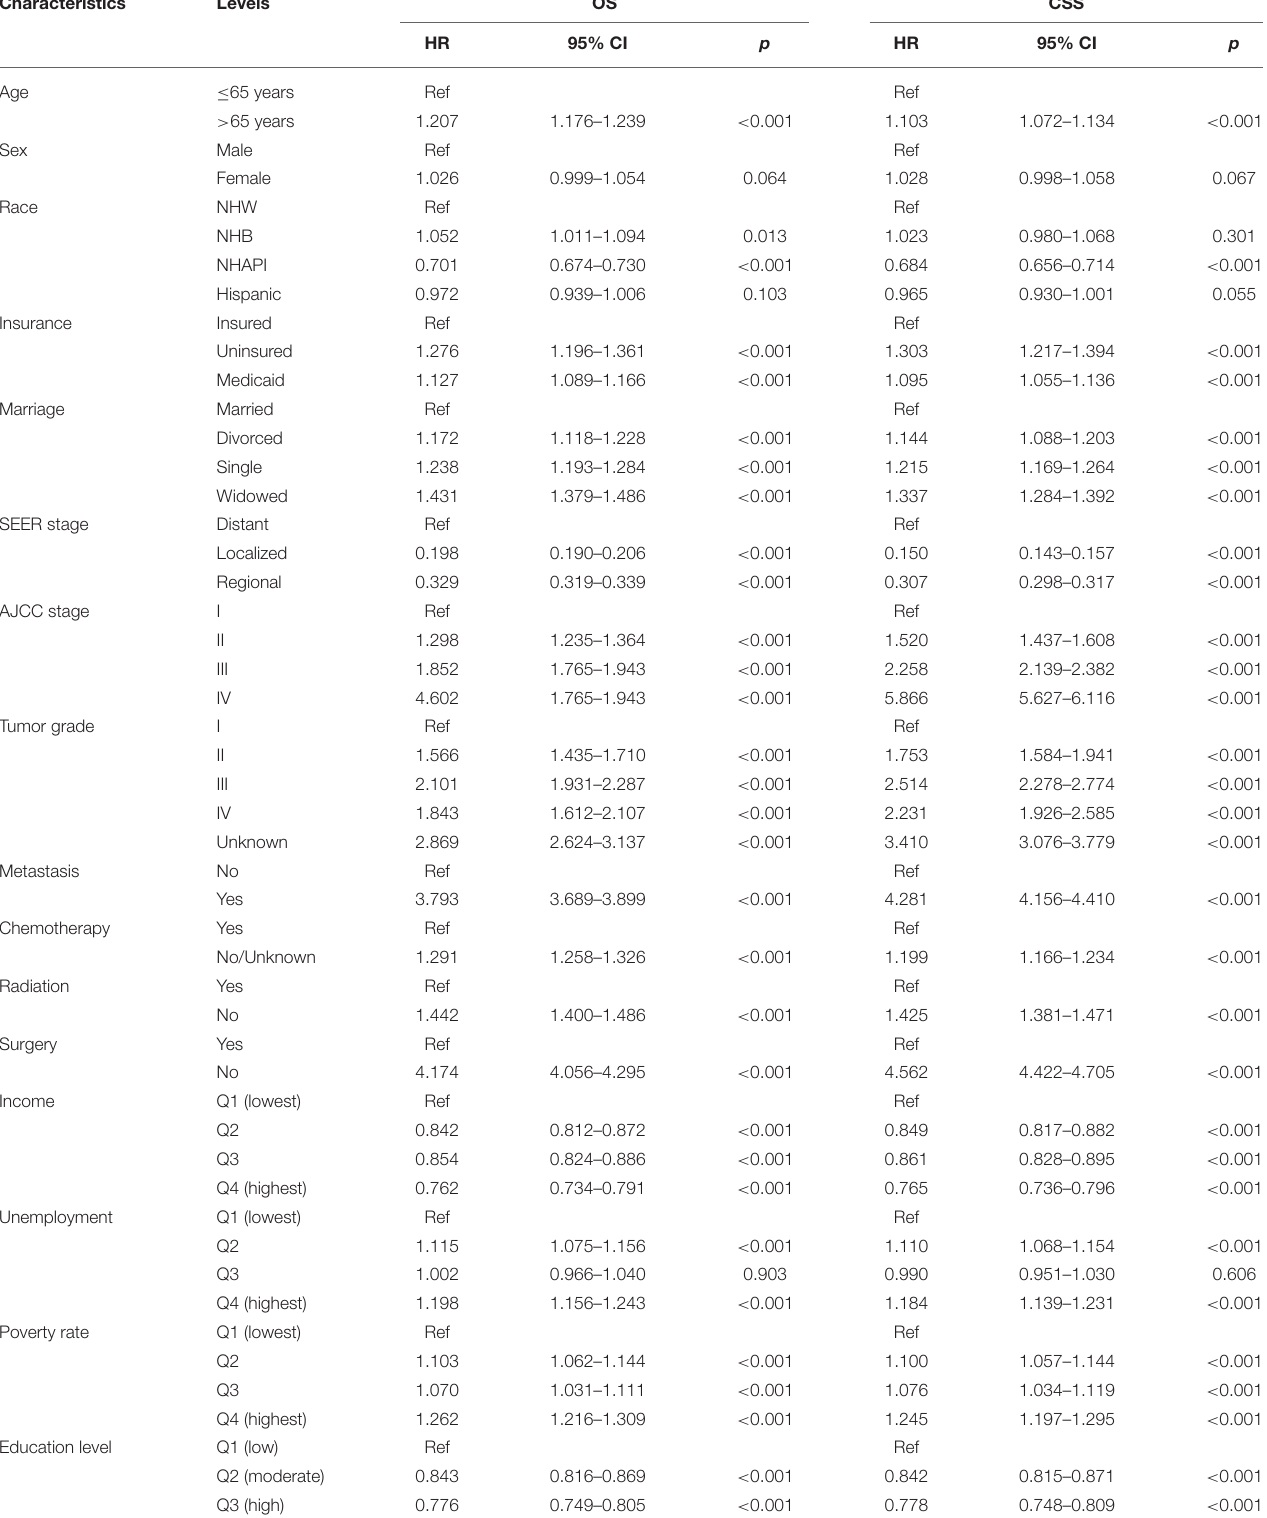
TABLE 2 | Univariate cox analysis of OS and CSS.